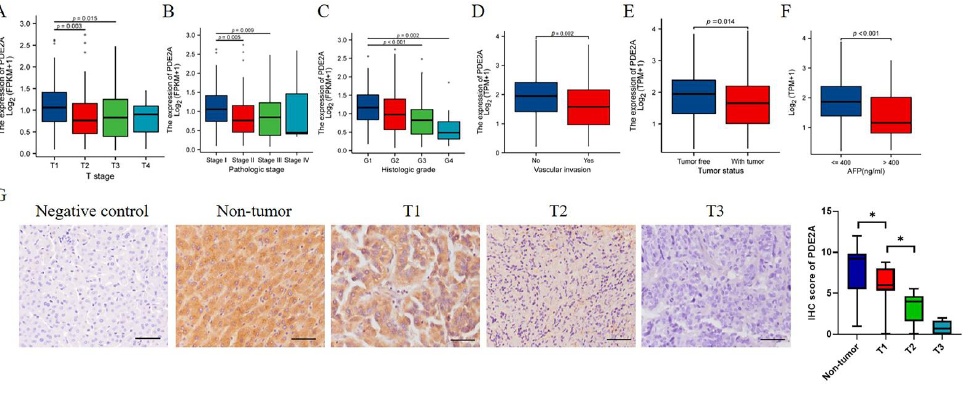
Figure 4. Associations of PDE2A expression and clinicopathological variables in HCC and immuno- histochemical (IHC) staining of PDE2A in HCC samples. The associations between PDE2A expression with T stage ( A ), Pathologic stage ( B ), Histologic grade ( C ), Vascular invasion ( D ), Tumor status ( E ), and AFP level( F ). ( G ) The representativeness images of PDE2A IHC staining results and the IHC score of PDE2A. Scale bar = 50 μm. AFP: alpha fetoprotein. * p < 0.05.